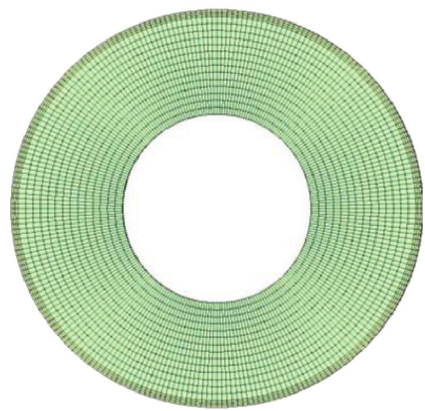
Figure 7: Finite element model of cosine